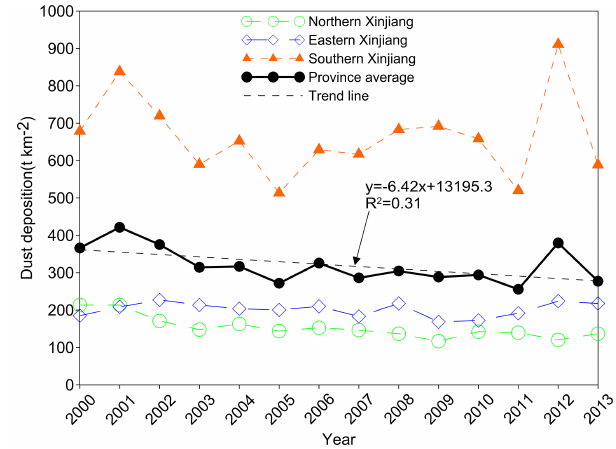
Figure 4. Monthly average dust deposition in Xinjiang Province from 2000 to 2013. Dust deposition in northern, eastern and south- ern Xinjiang is the average deposition at 8, 2 and 4 stations, respec-